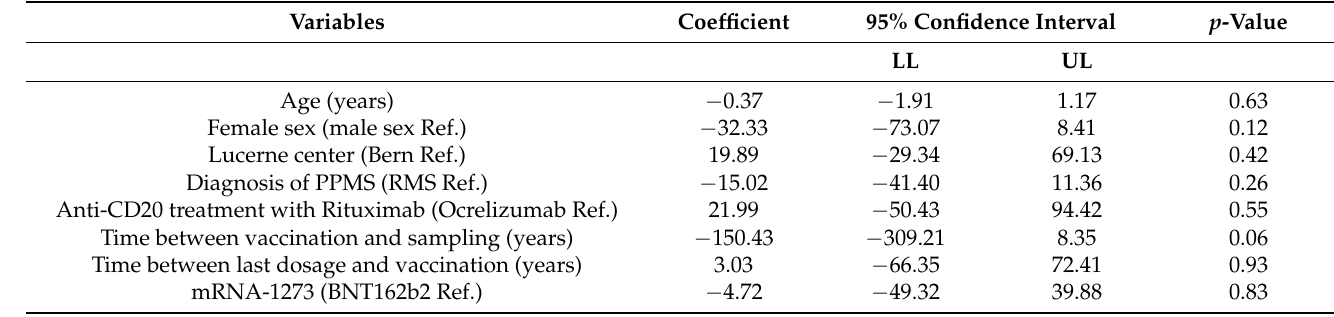
Figure 1. Anti-Spike IgG titer in anti-CD20 treated MS patients vaccinated twice, following the SwissMedic recommendations, with BNT162b2 or mRNA-1273 vaccine. Serum was used for analysis. Abbreviations: AU: arbitrary units, ml: milliliter. Table 1. Multivariable linear regression analysis with the dependent variable of anti-spike IgG (AU/mL) in anti-CD20-treated MS patients. Statistics: collinearity of each variance inflation factor (VIF) < 1.5, R 2 = 0.11, model ( p ) = 0.45. CI: confidence interval; LL: lower limit; Ref: reference; RMS: relapsing multiple sclerosis; UL: upper limit.